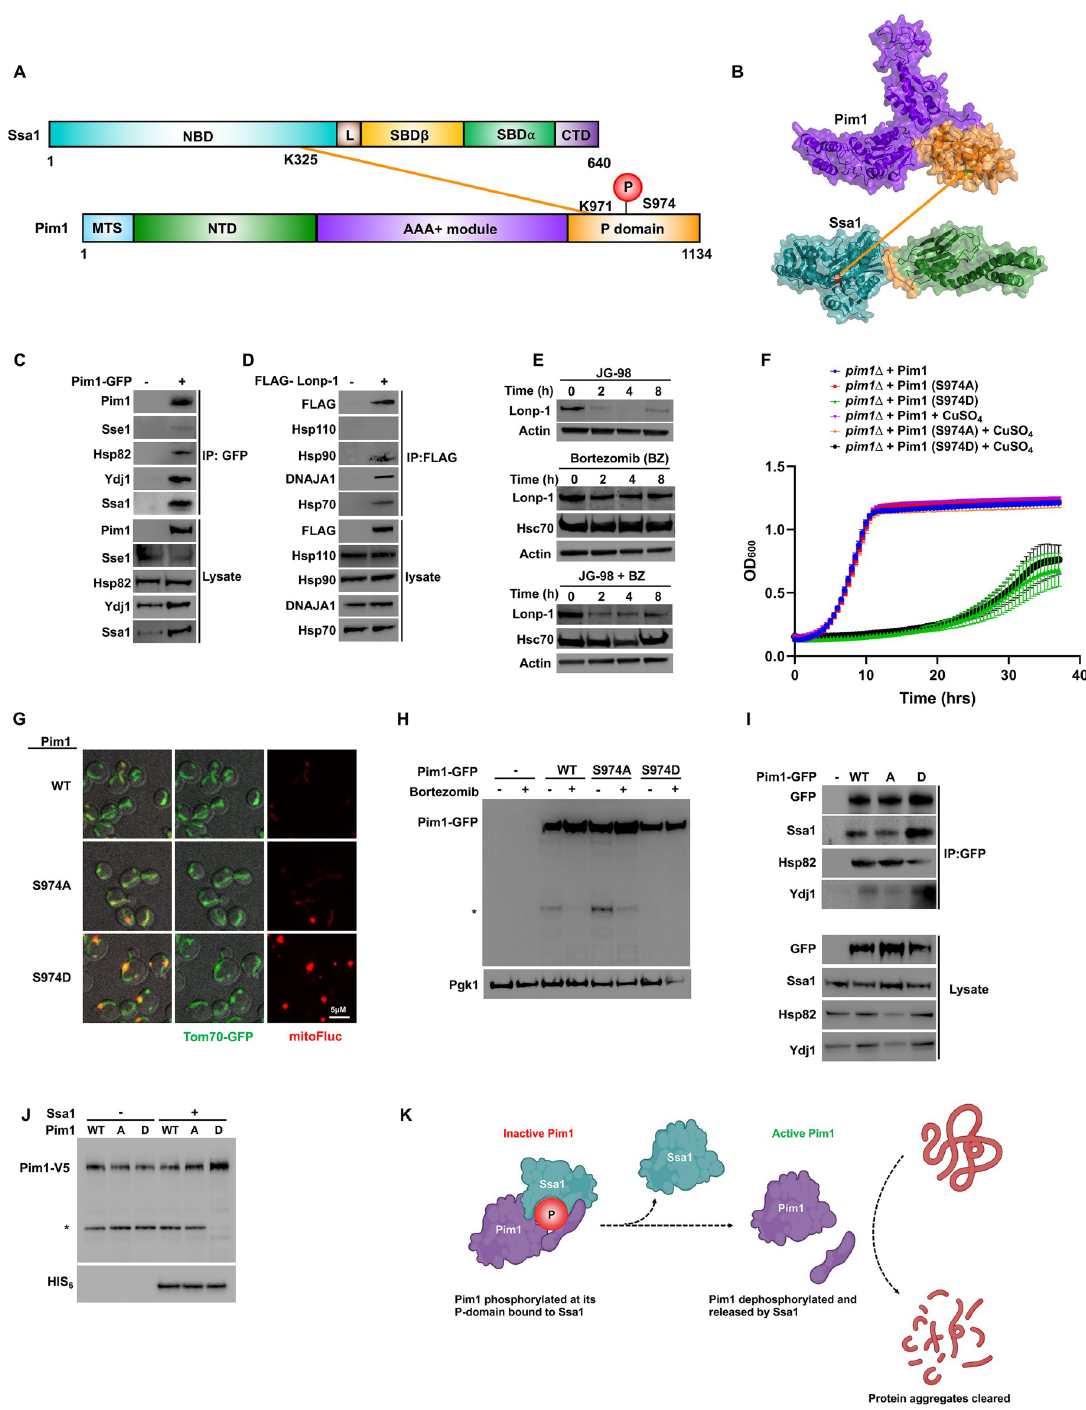
Fig 5. Activity of Pim1/Lonp-1 is regulated by interaction with Hsp70 and a novel phosphorylation site, S974. (A) Schematic representation of Ssa1-Pim1 inter protein cross-links detected on NBD of Ssa1 and proteolytic domain of Pim1. (B) Ssa1-Pim1 cross- links mapped on the crystal structures of Pim1 and Hsp70. (C) Pim1 interacts with the chaperone complex in yeast cells. Yeast expressing Pim1-GFP were grown to mid-log phase and Pim1-GFP complexes were isolated using GFP-TRAP beads. The purified Pim1-GFP complex was analyzed by SDS-PAGE/western blot analysis using indicated antisera. (D) Lonp-1 interacts with chaperone complexes in mammalian cells. HEK293 cells were transfected with a FLAG-Lonp-1 construct and after 24 h, total protein was extracted and FLAG-Lonp-1 complexes were isolated using FLAG Dynabeads. FLAG-Lonp-1 complexes were analyzed by SDS-PAGE/western